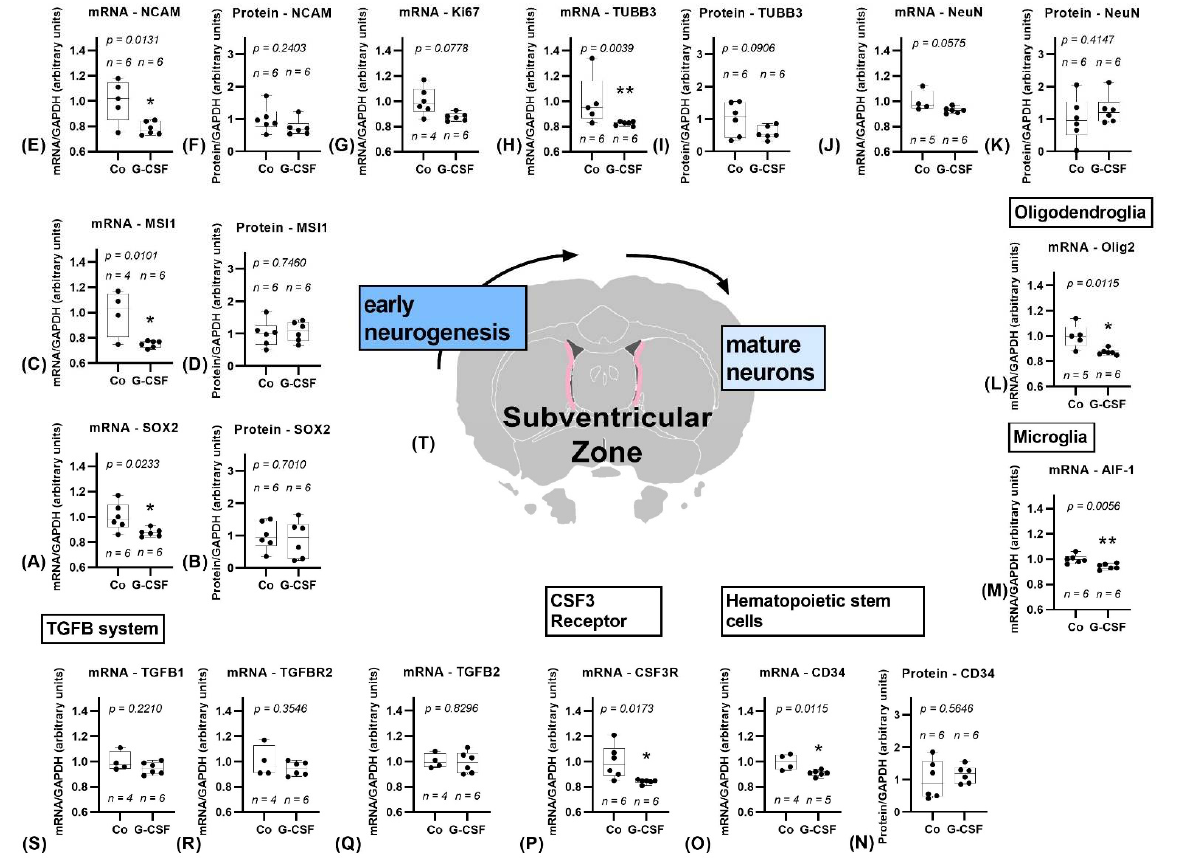
Figure 3. Study results of subventricular zone. The subventricular zone is marked pink in the cross section of the brain ( T ), position 0.43 mm anterior to bregma, image modified from Scalable Brain Atlas [36–39]. Controls are depicted left, G-CSF-treated animals are displayed on the right side of each graph. Significant downregulation of mRNA for markers of early neurogenic stages ( A – E ). mRNA of SOX2 ( A ), MSI1 ( C ), and NCAM ( E ) is significantly downregulated, protein shows no change ( B , D , F ). Ki67 shows a trend towards downregulation ( G ). mRNA of TUBB3 shows a significant downregulation ( H ), protein a trend towards downregulation ( I ). mRNA of NeuN shows a trend towards downregulation ( J ), protein has not changed ( K ). Oligodendroglial marker Olig2 is significantly downregulated ( L ). Microglial marker AIF-1 is significantly downregulated ( M ). mRNA of hematopoietic stem cell marker CD34 shows a significant downregulation ( O ), protein shows no change ( N ). CSF3 Receptor shows a significant downregulation ( P ). TGFB system is not affected ( Q – S ). All parameters were tested for Gaussian distribution using the D’Agostino–Pearson omnibus normality test. Afterward, all parameters were analyzed using a two-tailed Student’s t -test or Mann–Whitney test, depending on Gaussian distribution. Data are presented as median with min to max. Significance was observed at p ≤ 0.05 (*), p ≤ 0.01 (**), a trend was noticed at p ≤ 0.1. Numbers (n) are given for each